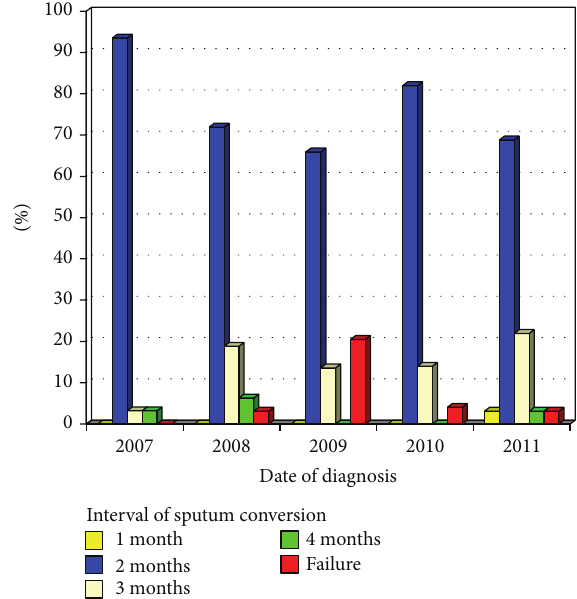
Figure 1: Time of sputum smear conversion of pulmonary tubercu- losis regarding years of study.